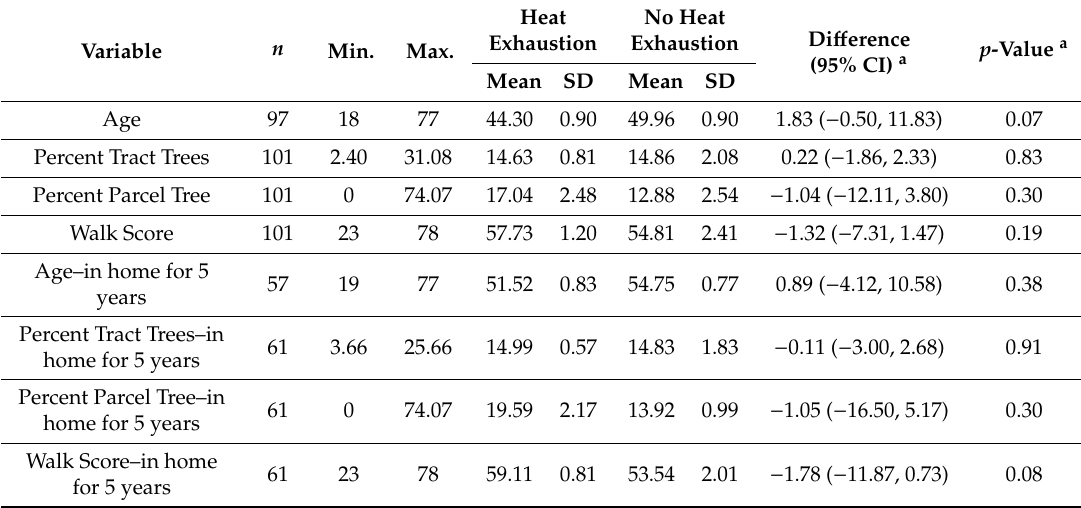
Table 2. Means and t-tests of experiencing vs. not experiencing heat exhaustion in the previous five years by respondent age and neighborhood characteristics for all study participants providing addresses ( n = 101) and for those residing in their homes in the previous 5 years ( n = 61) in Detroit, MI, 2016–2017.